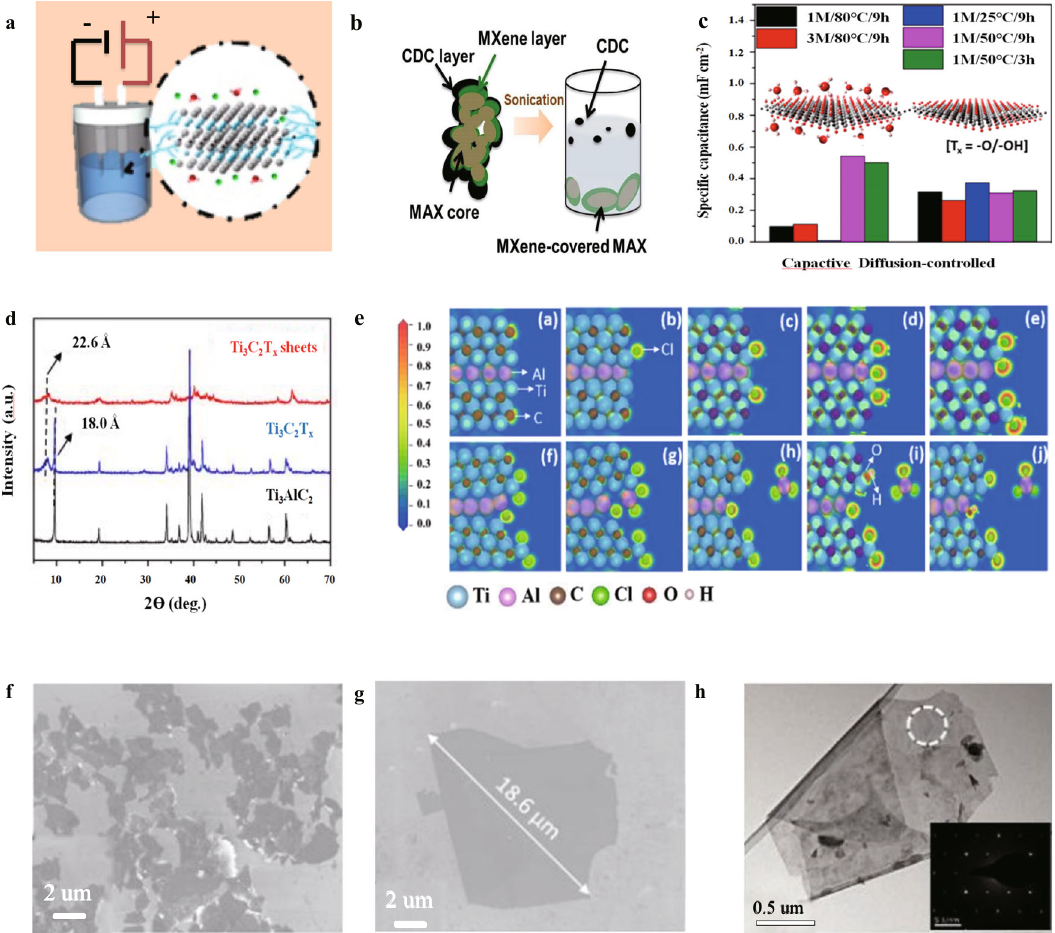
Fig. 4 The synthesis of MXenes from MAX phase by electrochemical etching. a The con fi guration of electrochemical cell. b The potential mechanism for electrochemical etching of Ti 2 AlC with HCl as electrolyte 55 . Copyright 2017, Royal Society of Chemistry. c The mechanism of pseudocapacitive contribution of various Ti 2 CT x 57 . Copyright 2019, American Chemical Society. d X-ray diffraction patterns of Ti 3 AlC 2 , Ti 3 C 2 T x , and Ti 3 C 2 T x fi lms. e Electron localization function plots for pristine and etched Ti 3 AlC 2 . f – g SEM images and h TEM image of the delaminated